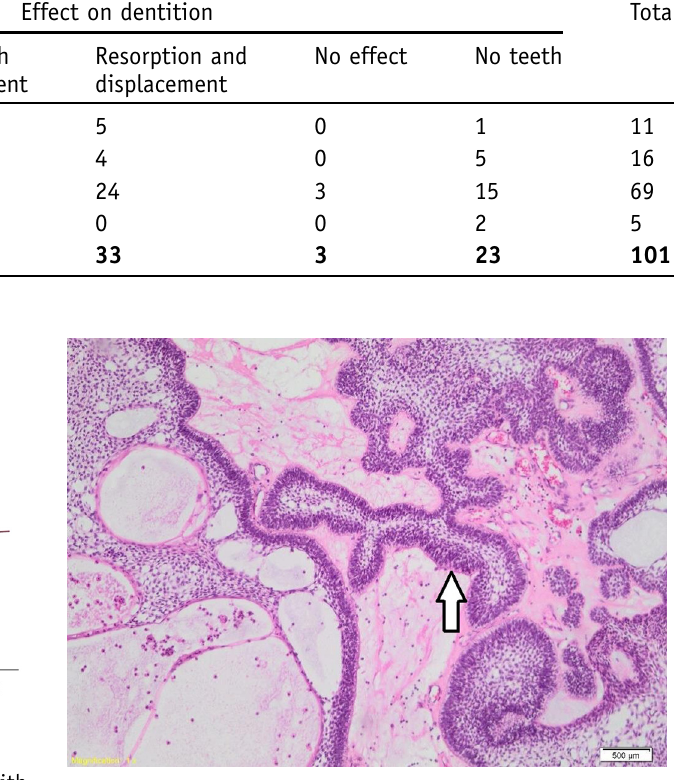
Fig. 7. H&E stained specimen showing plexiform ameloblastoma.